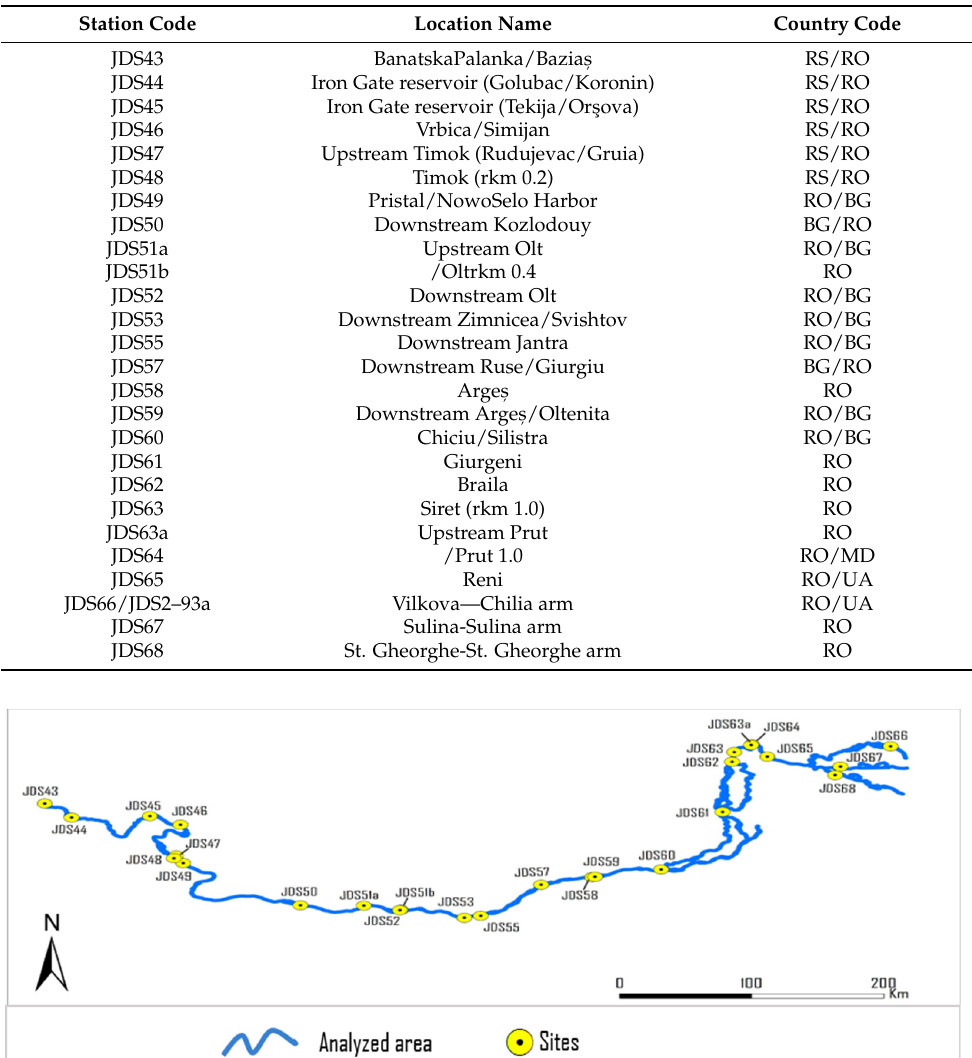
Table 3. Romanian Danube JDS3 (26) sampling stations (according to Liška et al. [54]).